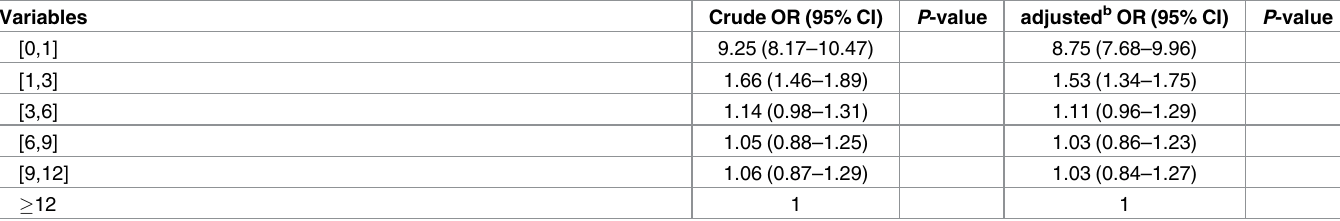
a Mean number of patients with planned dialysis start through the 20 imputed data sets. b ORs adjusted for year of hemodialysis initiation and region’s annual percentage of patients with predialysis arteriovenous access creation in addition to all variables in Table 1. Abbreviations: OR: odds ratio; CI: confidence interval; ESA, erythropoiesis-stimulating agents; MDRD, Modification of Diet in Renal Disease; AV,